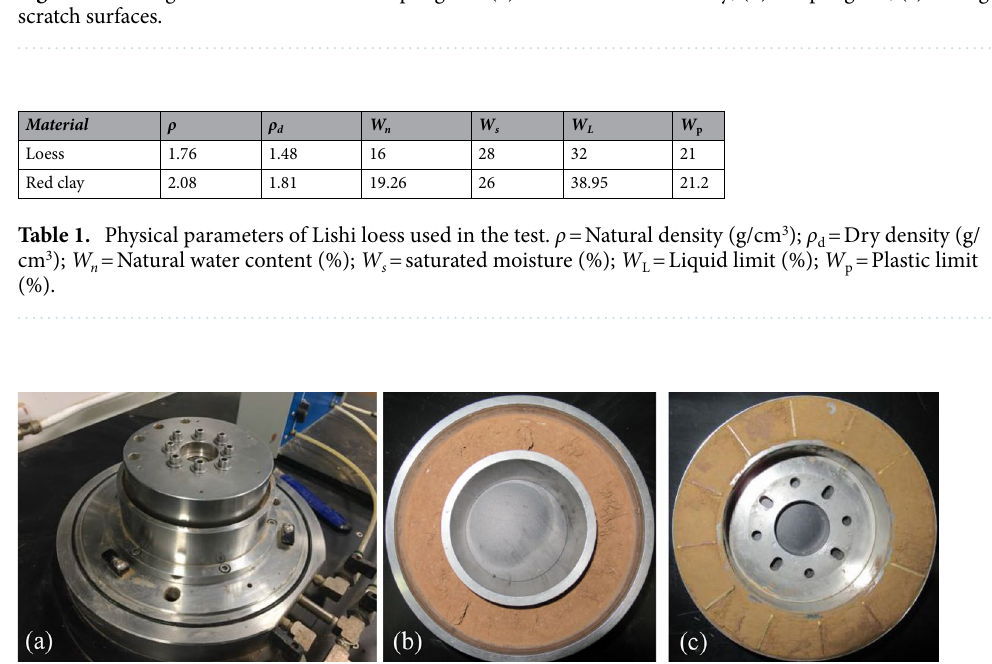
Figure 3. A sheared specimen. ( a ) Ring shear chamber; ( b ) the bottom platen with sheared soil; ( c ) the top platen with sheared